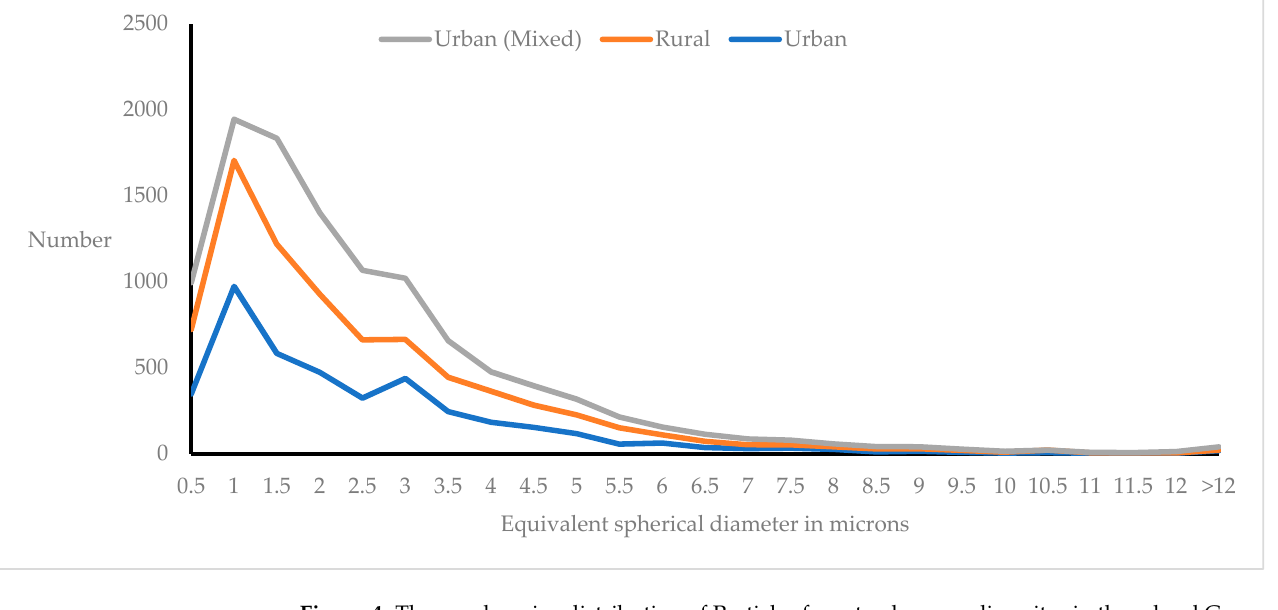
Figure 4. The number-size distribution of Particles from twelve sampling sites in three local Government Areas.